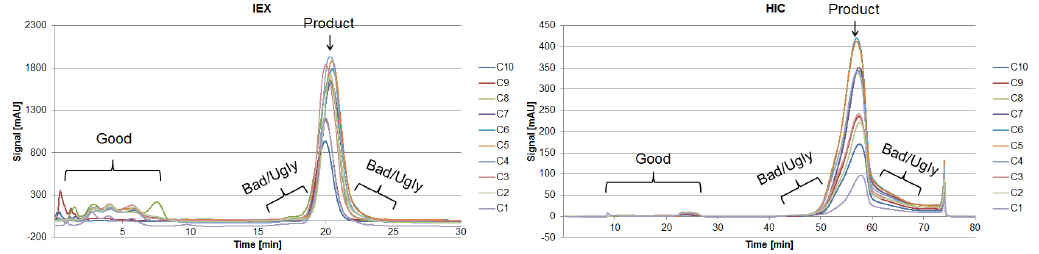
Figure 9. Chromatograms of the IEX ( left ) and HIC ( right ) after various cycles in the iCCC mode. Impurities with a pI range close to the target protein (i.e., 7.30–9.30) are more difficult to separate via an IEX and are therefore considered “Ugly.” However, since the separation efficiency of